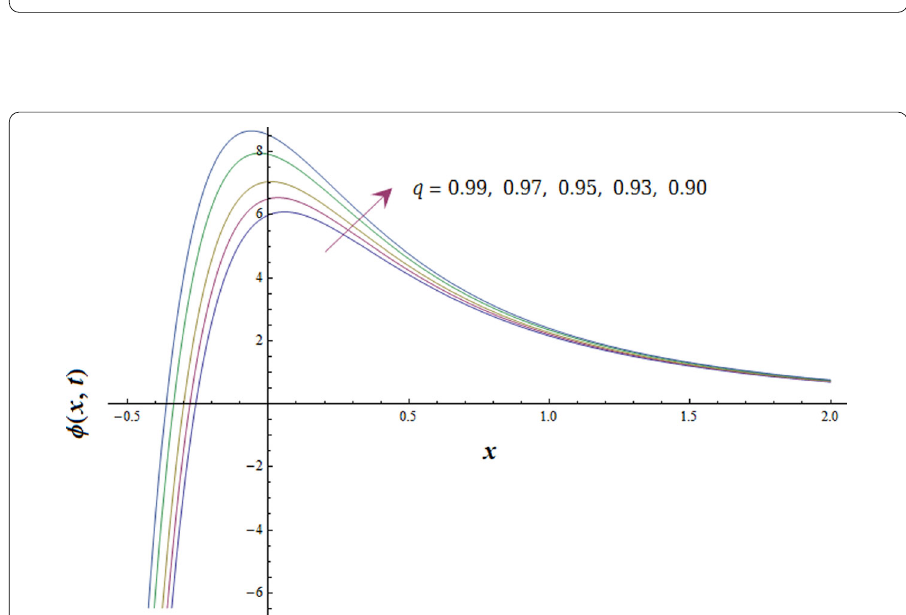
Figure 4 Behavior of the solution with respect to the different values of